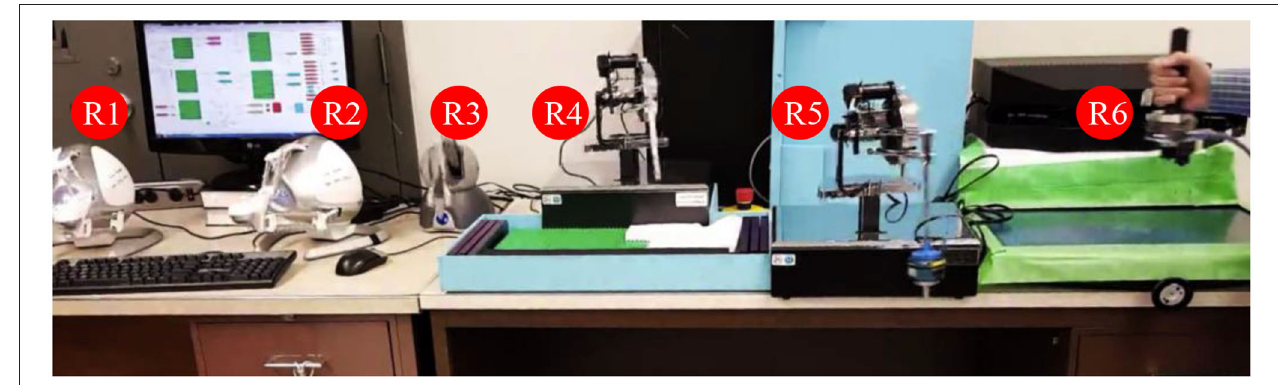
FIGURE A1 | In this figure, six non-homogeneous robots participate in a rehabilitation process as discussed in Figure A2 . A dual set of Novint Falcon ® , one Phantom Omni ® , Two Phantom Premium ® robots, and one Quanser ® robot participate in the process, forming R1–R6, respectively.